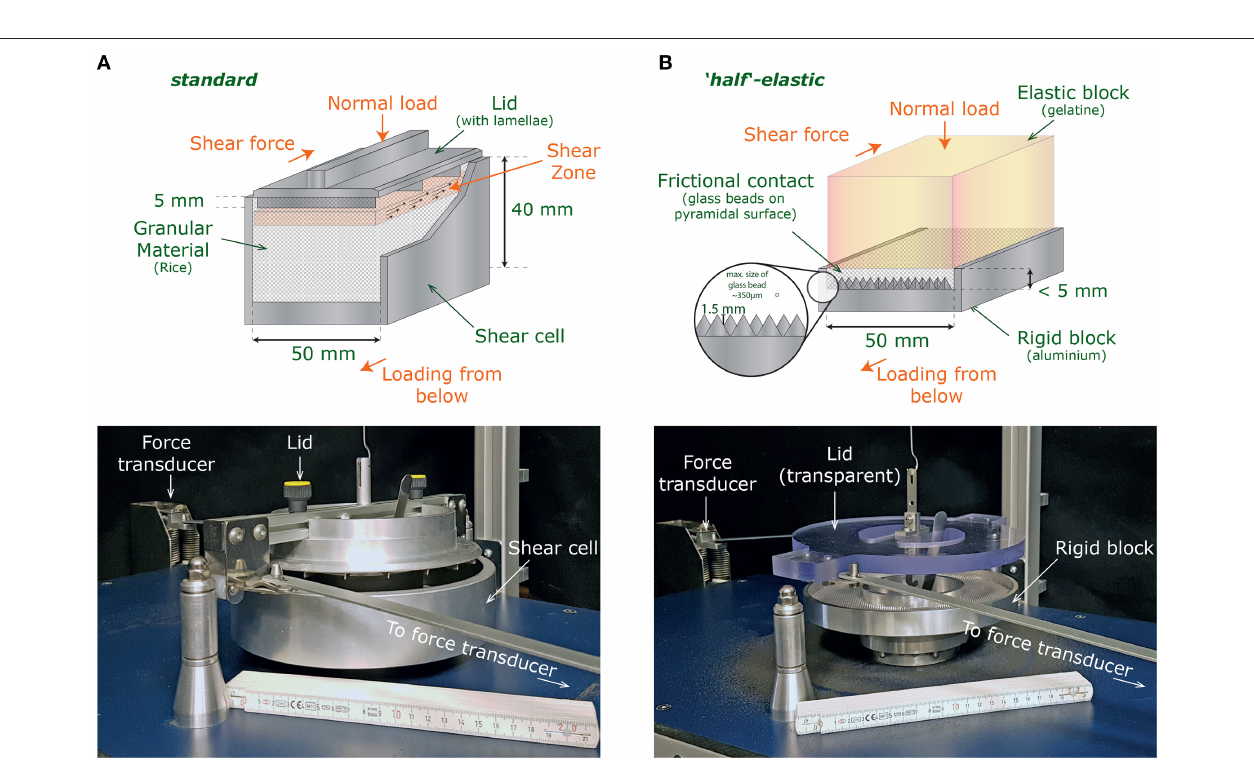
FIGURE 2 | Schematics and photographs of the setups on which the trigger algorithm is tested. (A) Standard configuration with cell and high stiffness. The basal cell is rotated while the lid is stationary and used to measure the shear force. According to Schulze (1994), a shear zone forms below the lamellae within the glass beads. (B) Half-elastic configuration with a rigid base block, an elastic gelatine ring with a layer of glass beads in between. Here the shear zone originates at the contact between gelatine and glass beads.